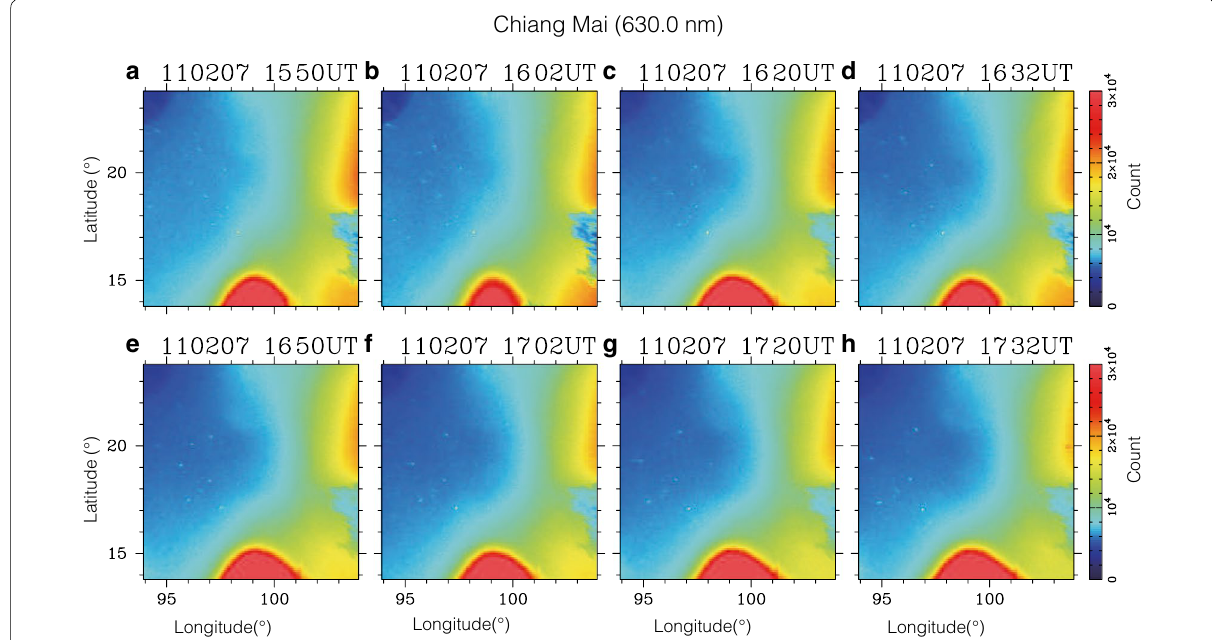
Fig. 4 Two-dimensional 630-nm airglow images from 1550 to 1732 UT on February 7, 2011, at Chiang Mai represented as raw CCD counts. These images are converted from all-sky coordinates to geographic